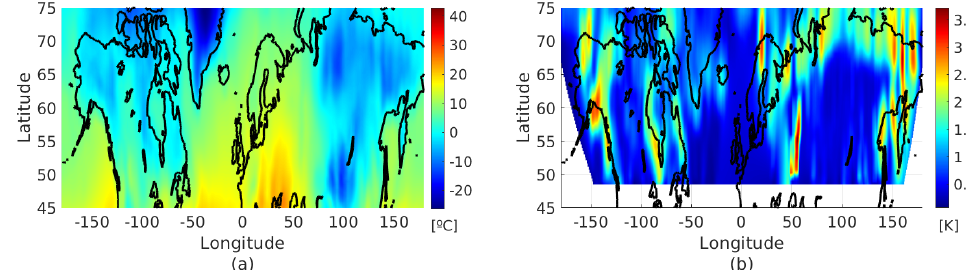
Figure 6. ( a ) Low resolution skin temperature (ºC), and ( b ) sample FMPL-2 standard deviation (ºK) in the along-track direction after applying the NNI algorithm. Note that land-water transitions in the northern part of Siberia are highlighted in